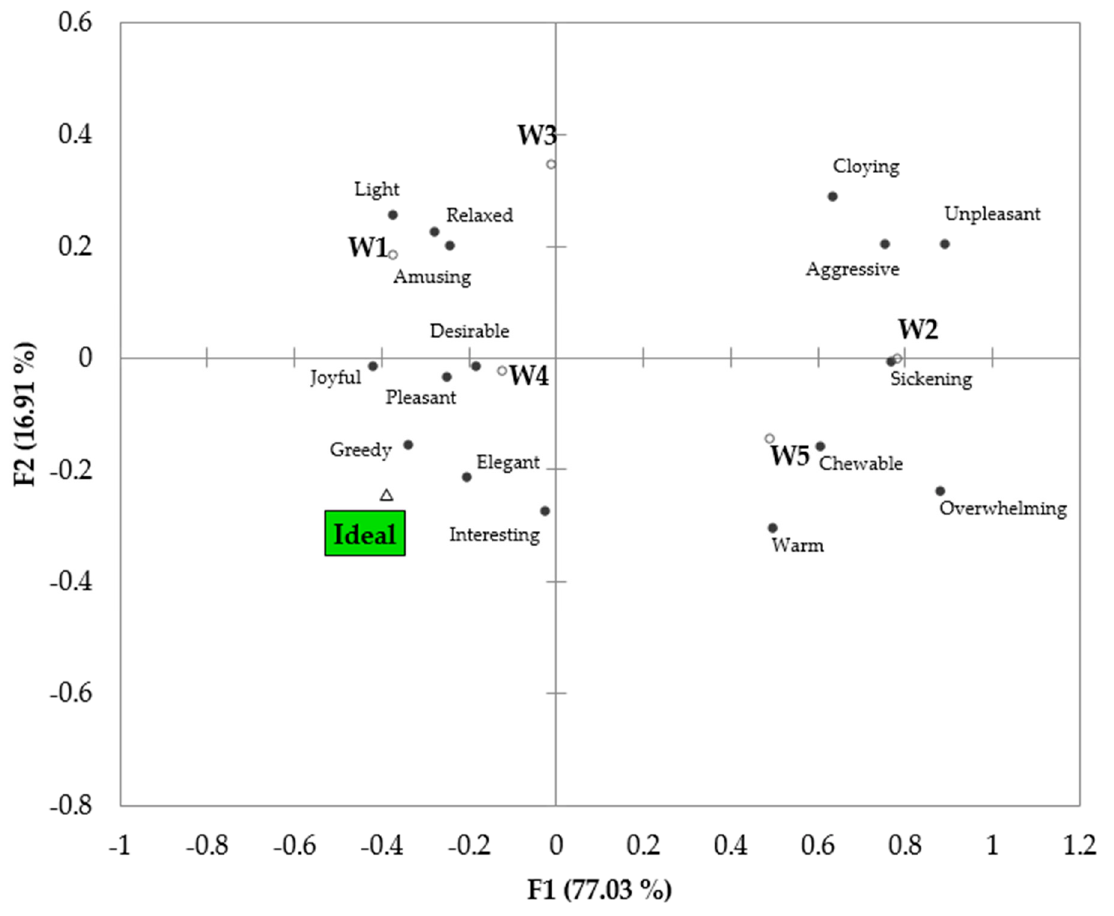
Figure 5. PCA plot of wines in relation to the ideal wine (W) according to emotional responses.